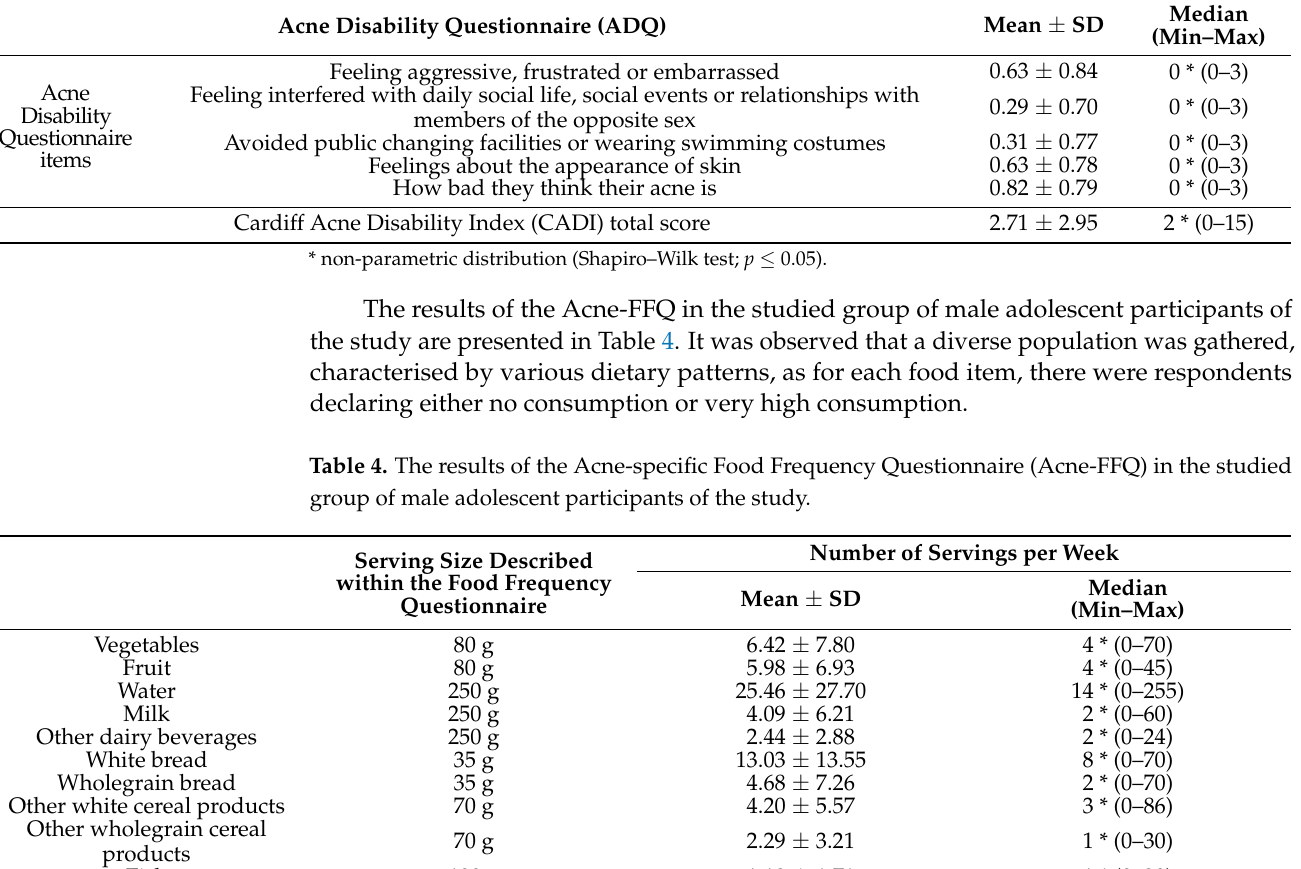
Table 3. The results of the Cardiff Acne Disability Index (CADI) obtained based on the Acne Disability Questionnaire (ADQ) in the studied group of male adolescent participants of the study.